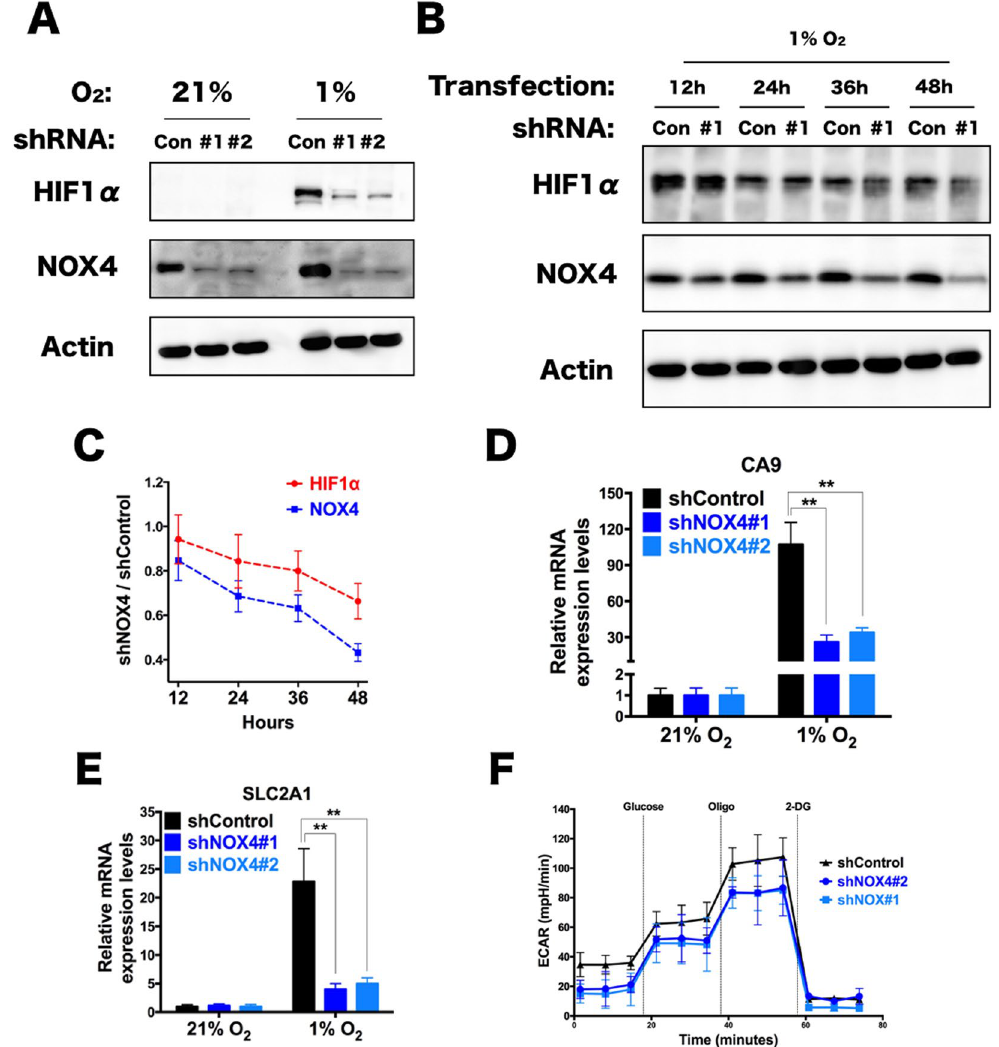
Figure 3. HIF1 α stabilization and glycolysis require NOX4 expression. ( A ) Immunoblots of NOX4 knockdown cells and its Control respectively cultured under 21% O 2 and 1% O 2 for 48 hours. ( B,C ) Immunoblot of TPC-1 cells grown in 1% O2 for 48 hours after tranfected with shRNA vector targeting NOX4 for the indicated time points ( B ). Levels of HIF1 α and NOX4 quantified using Image J and normalized to actin ( C ). ( D,E ) TPC-1 cells expressing shControl or shRNA against NOX4 (shNOX4#1,#2) were cultured in 21% O 2 and 1% O 2 (48 hours), and the fold change in CA9 ( D ) and SLC2A1 ( E ) levels was measured by qRT-PCR. ( F ) The extracellular acidification rate (ECAR) was measured in TPC-1 cells expressing shControl or shRNA against NOX4 (shNOX4#1,#2) cells treated with 1% O 2 (48 hours). Data show a representative experiment (from 3 independent experiments). Error bars ± SD (n =